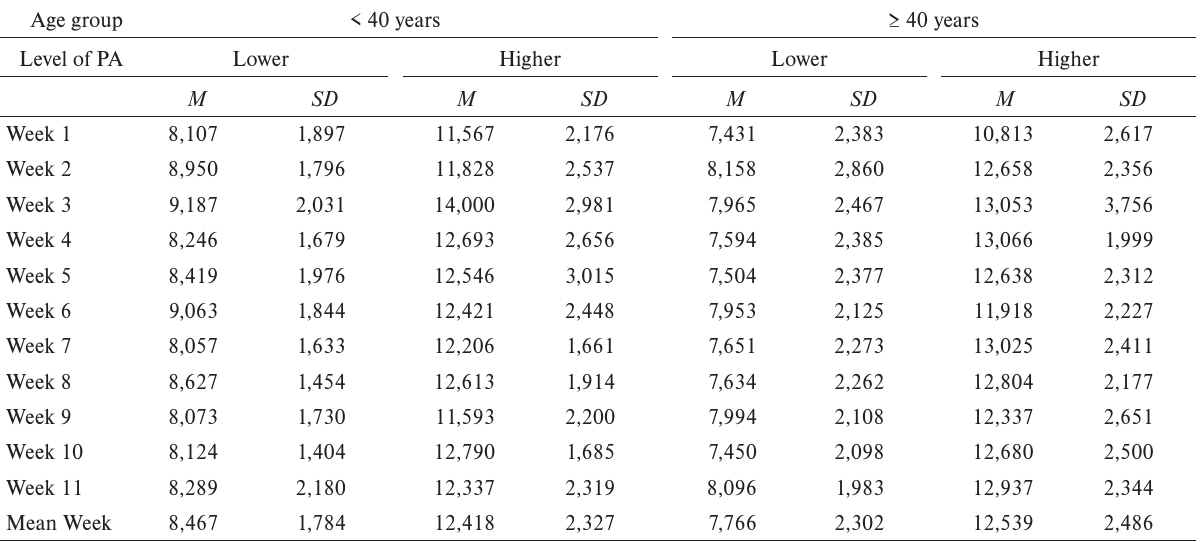
Table 1 Number of footsteps per day within each week in relation to age and physical activity Age group < 40 years Level of PA